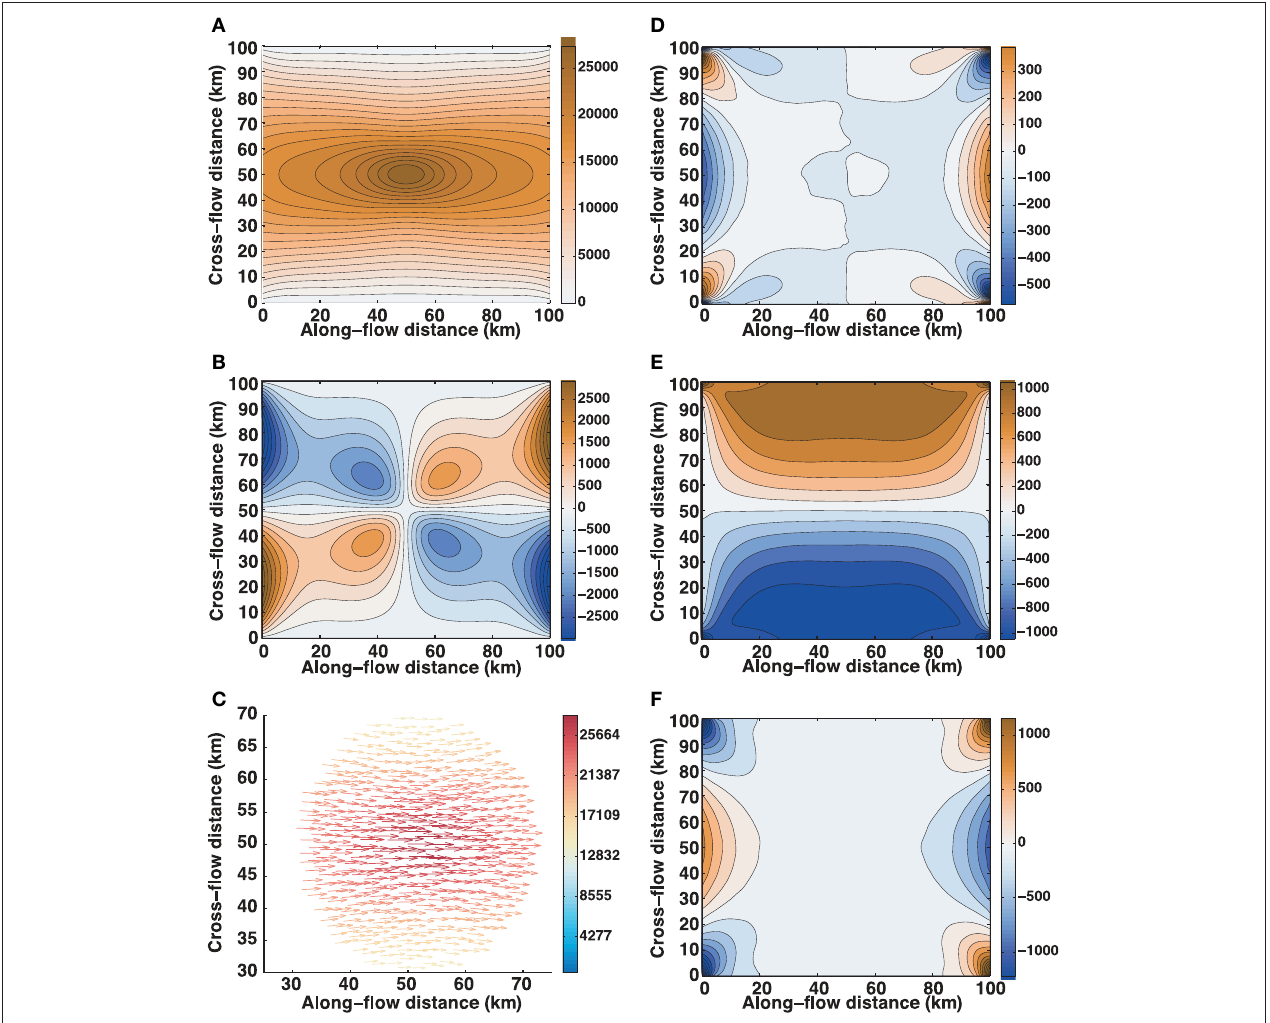
FIGURE 4 | Perturbation at t = 12 h + 10min: (A) along-flow velocity; (B) cross-flow velocity; (C) vector velocity (colored by magnitude) within 20 km of sticky-spot center; (D) along-flow stress; (E) shear stress; (F) cross-flow stress. Velocities in m a − 1 , stresses in Pa. Mean velocity is from left to right in the positive along-flow